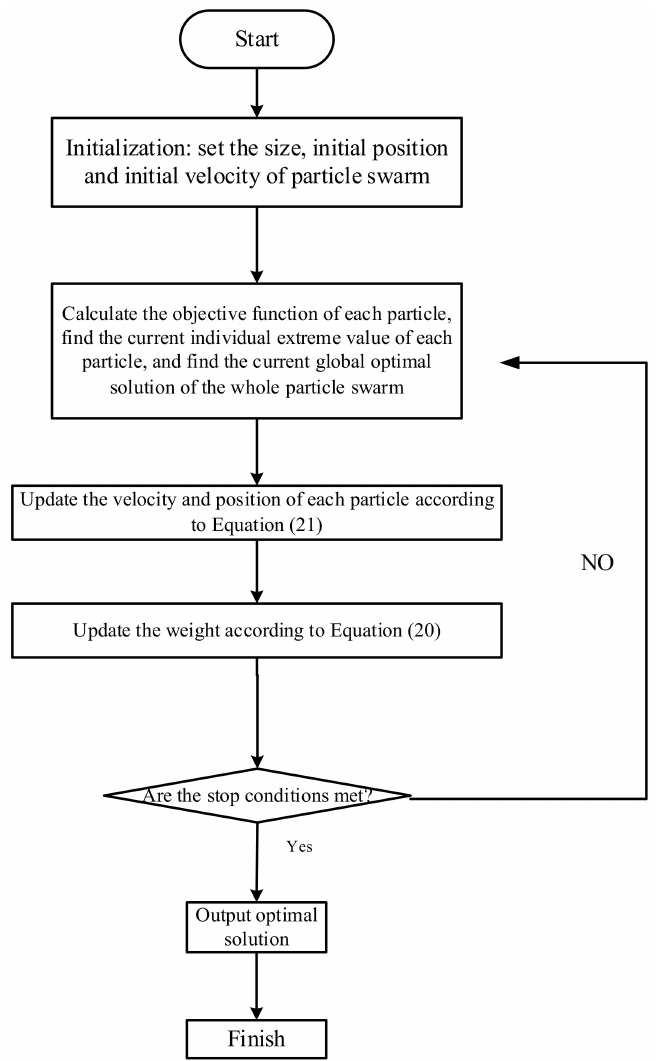
Figure 4. Flow chart of adaptive weight particle swarm optimization algorithm. In the optimization process, the suspension parameters of a vehicle are referred to (as shown in Table 1 [46]). To more accurately search for the optimal individual extreme value and global optimal solution, 40 particles were randomly selected for iterative op- timization. The maximum inertial weight of the learning factor l 1 = l 2 = 1.49445 is 0.9, and the minimum inertial weight is 0.6. After 100 iterations, the variation diagram of the iteration number of the fitness function of the suspension performance index is shown in Figure 5. It can be seen that with the continuous evolution of the population, the fitness function value of the optimal individual decreases rapidly. The number of invalid itera- tions is lower, and the convergence is fast. Finally, the global optimal control parameters under harmonic excitation and random excitation are obtained: g = 18,815.1534673518, − 33,108.79988701554, τ τ = 0.868044394480619. g 1 = 2 = 0.992053286298810 It is carried to the I region of ζ 2 = c 2 √ , g 1 = g , in which the feedback control parameters can be k 1 m p k 2 determined in the time-delay stability region. According to Theorem 1, the control system at this time is stable with full delay, and the system does not have stability switching; that is, the system is